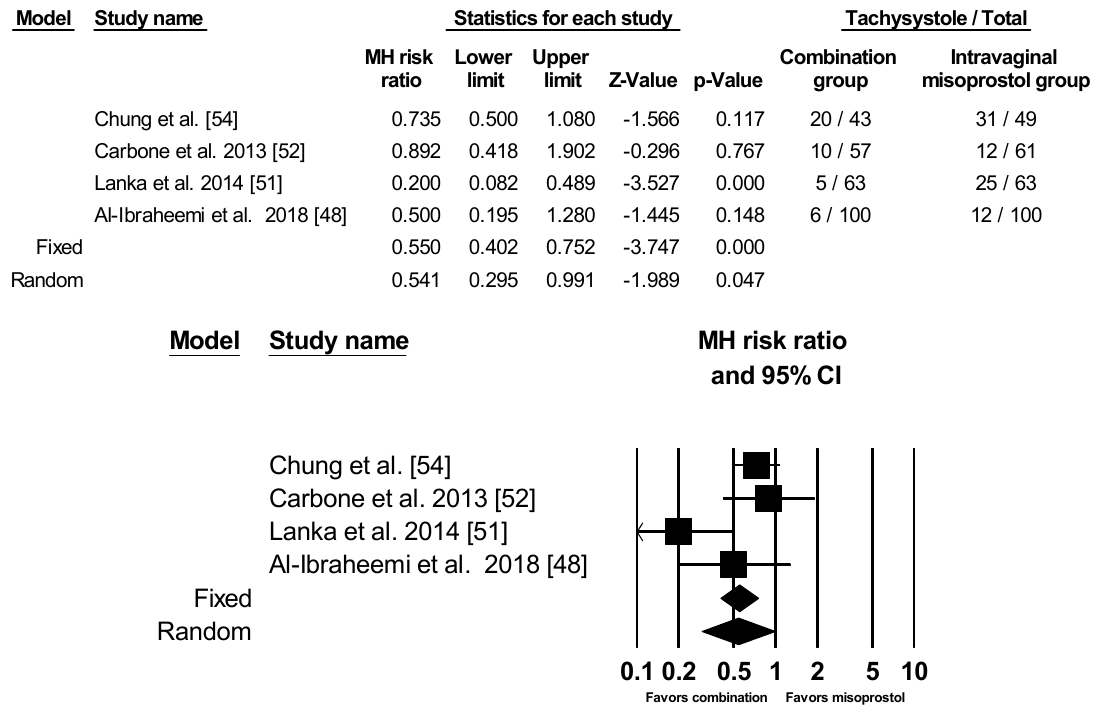
Figure 6. Comparison 5: Combination of intracervical Foley catheter and intravaginal misoprostol versus intravaginal misoprostol alone for cervical ripening, Outcome 5: Tachysystole. Heterogeneity: Tau 2 = 0.242; ꭓ 2 = 8.705, df = 3 ( p = 0.033); I 2 = 65.536%. Test for overall effect (random): Z = − 1.989, ( p = 0.047)